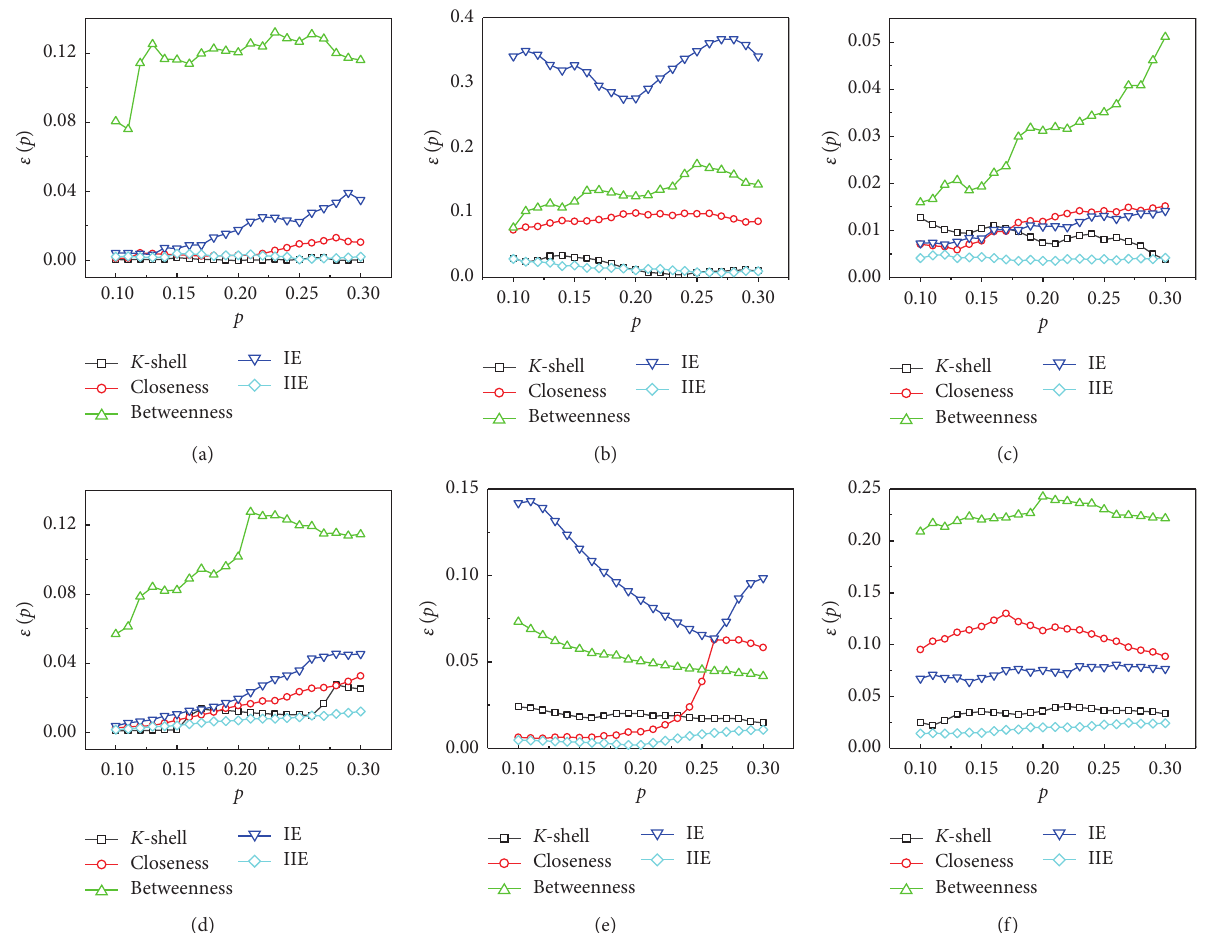
Figure 6: (Color online) This experiment compares different methods by using the imprecision functions ε proportion of selected nodes, p ∈ [ 0 , 1 ] . We set β � 0 . 2 and μ � 1. The results were calculated from an average of 10 3 experiments. (a) US air. (b) Polblogs. (c) E-mail. (d) Soc-hamsterster. (e) Facebook. (f)